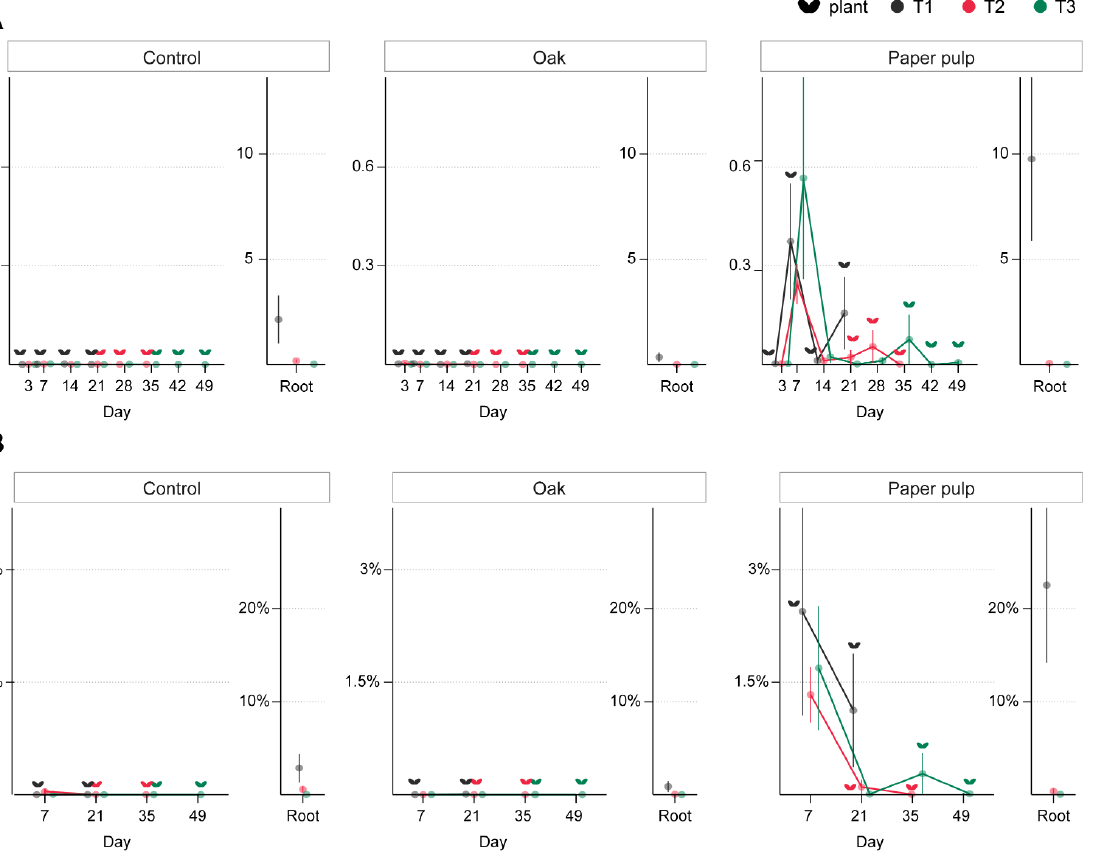
Figure 8. R. solani abundance in soil amended with oak sawdust and paper pulp and sown at three time points after amendment. ( A ) R. solani copy number was determined with qPCR in soil of both planted and unplanted pots at 1, 3, 7, 14, 21, 28, 35, 42, and 49 days after amendment ( x -axis) and in roots (as mean ± se , n = 5). ( B ) R. solani relative abundance was quantified by ITS amplicon sequencing in soil at 7, 21, 35, and 49 after amendment ( x -axis) and in roots (as mean ± se , n = 5). Plant symbols next to each data point indicate that soil samples were obtained from planted pots.